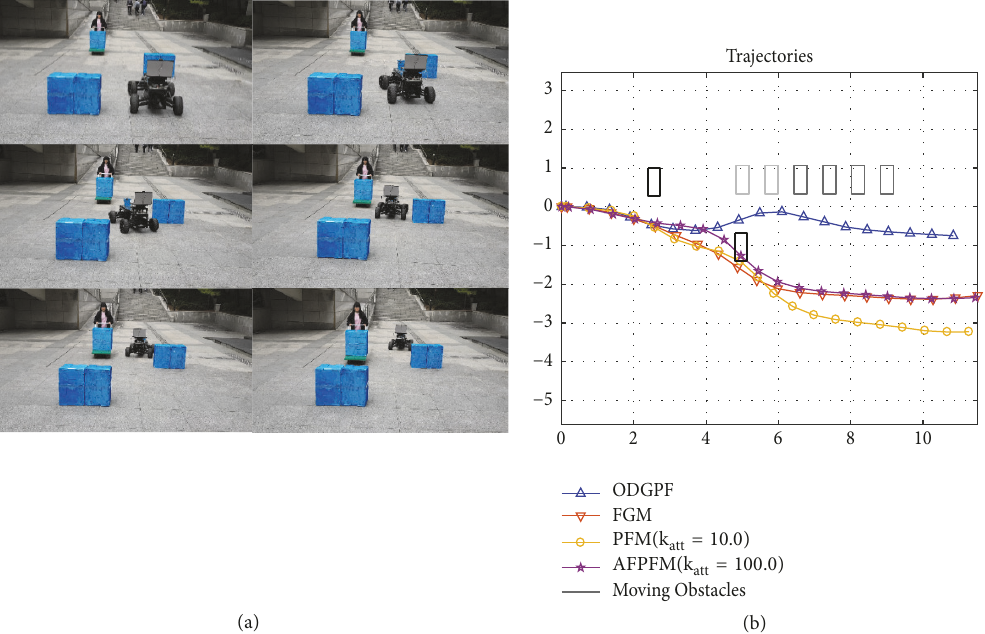
Figure 18: Experimental results of the vehicle with ODG-PF for Scenario 1.